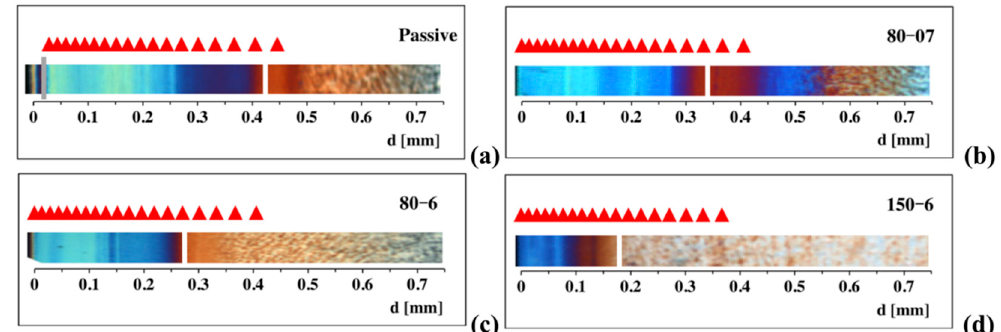
Figure 5. Comparison between experimental observation for the layers with oriented morphological elements of thickness not larger than 4 μ m [20] (white marks) and predictions of the criterion obtained with Δ c and W c equal to 7 and 10 MPa respectively (red triangles).( a ) Passive test; ( b ) 80-07 test; ( c ) 80-6 test; ( d ) 150-6 test.